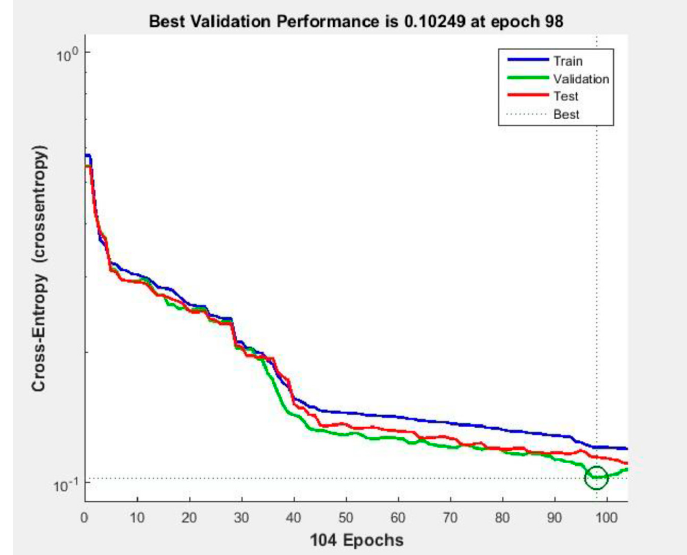
Figure 11. Characteristics of error changes during the learning process of a network using second-degree polynomial coefficients.